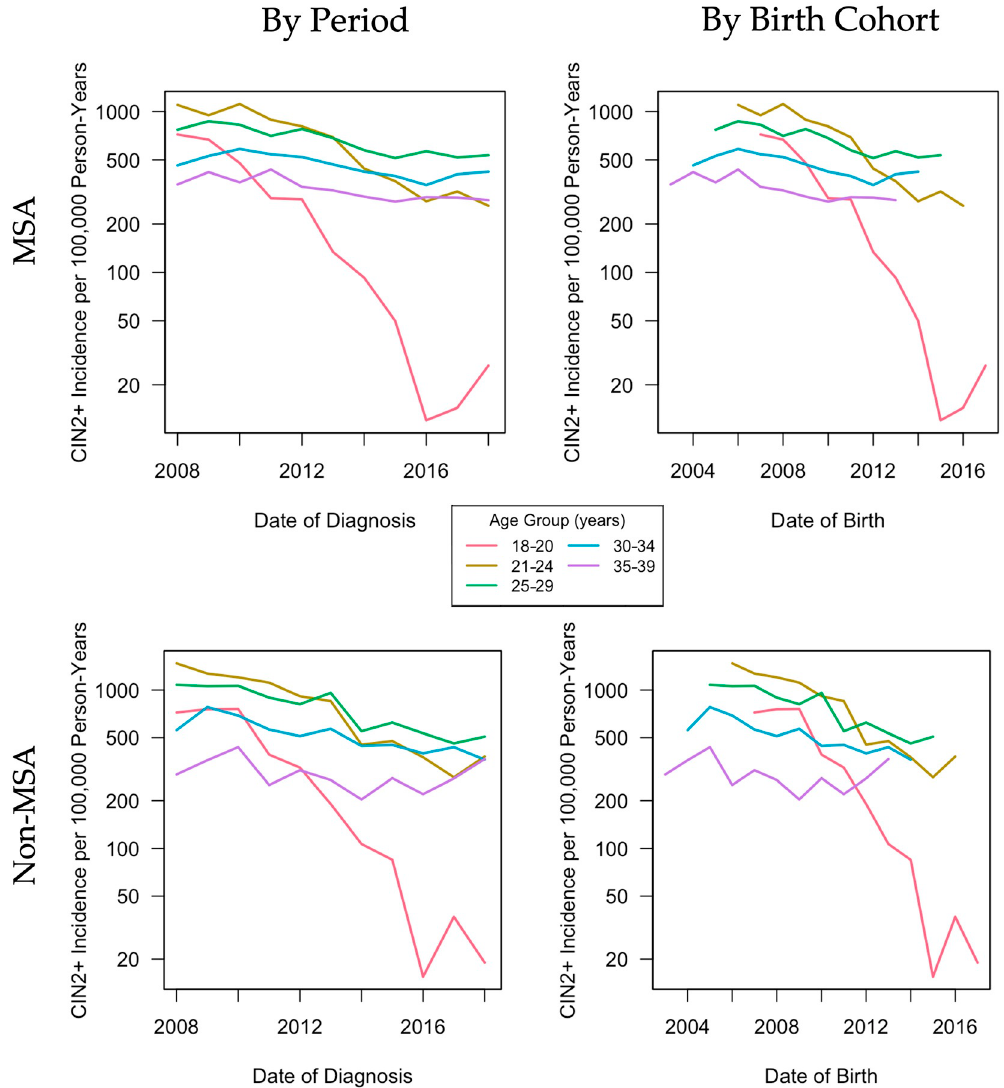
Figure 2. Age-group-specific CIN2+ incidence per 100,000 person-years by period and birth cohort among all women enrolled in Tennessee Medicaid. CIN2+: cervical intraepithelial neoplasia grades 2 and 3 and adenocarcinoma in situ; MSA: metropolitan statistical area.